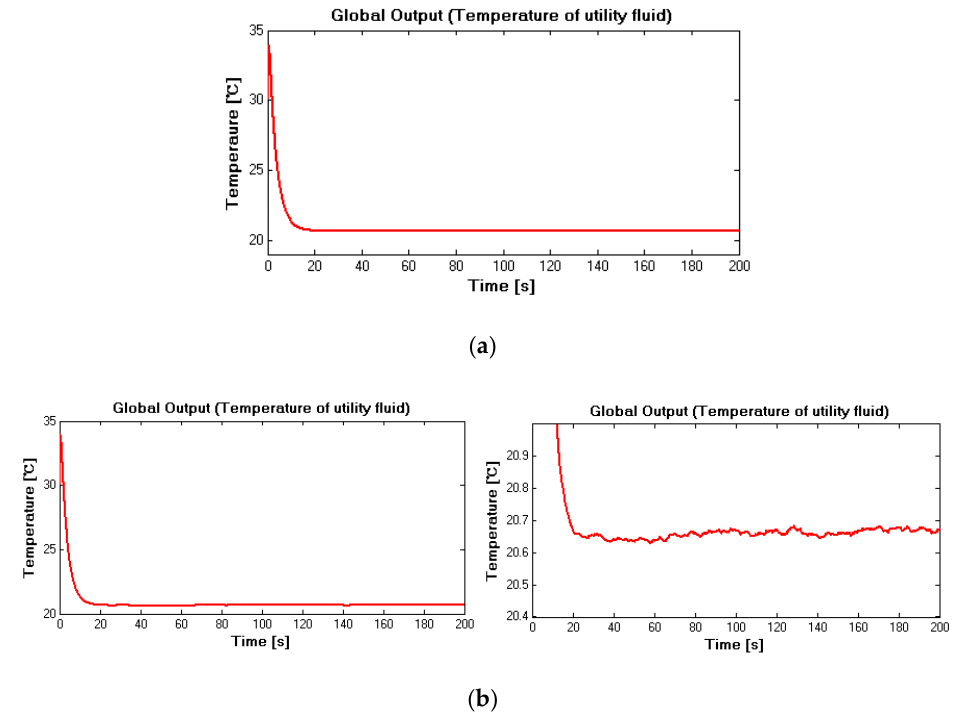
Figure 5. ( a ) Measured T C (noise-free situation) in case 1; ( b ) measured T C (noise-corrupted situation) in case 1.